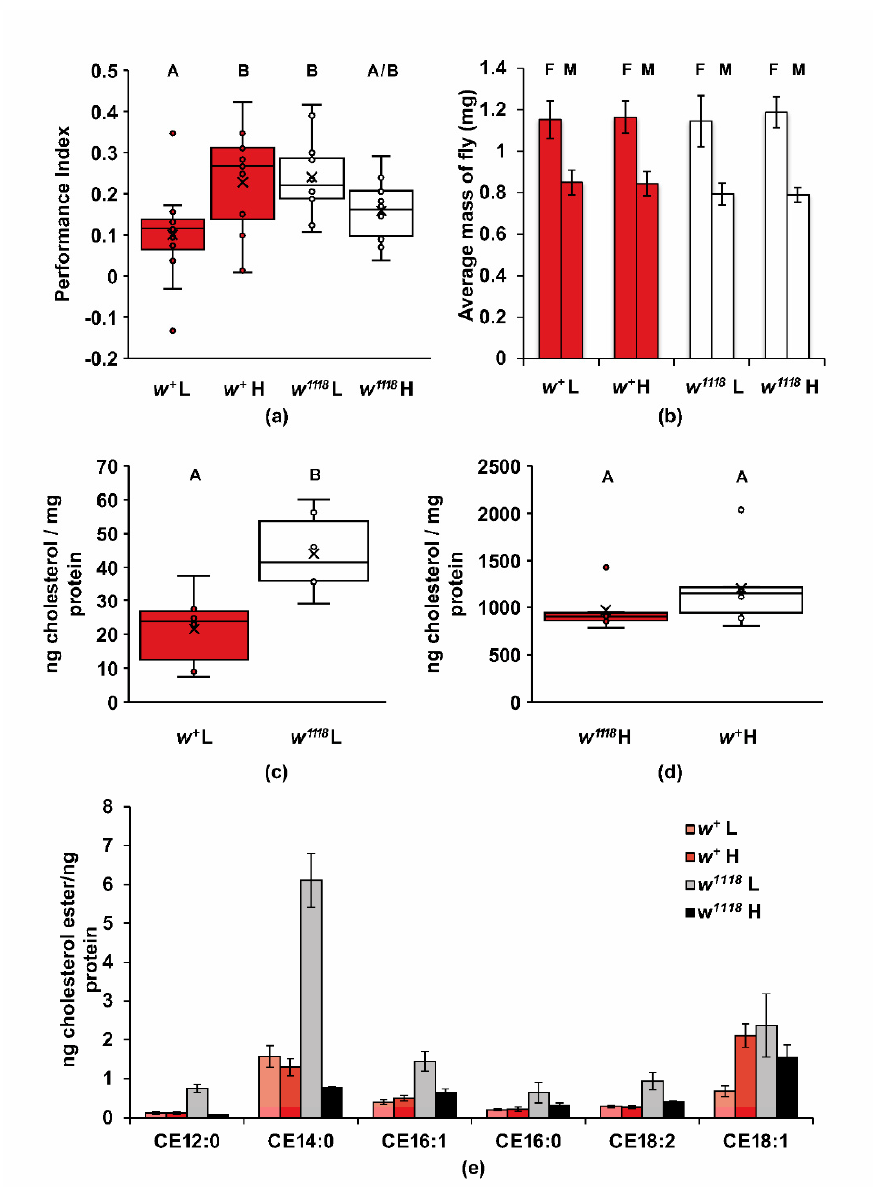
Figure 4. The w 1118 mutants have differential responses to dietary cholesterol in one-trial learning and in cholesterol accumulation in their corpses. Canton-S ( w + ) and w 1118 flies were reared on a low- or high-cholesterol (0.1 mg/mL added) diet. ( a ) Dietary cholesterol had a significant effect on one-trial learning (two-way ANOVA, Adj. R 2 = 0.183, F 3,44 = 4.508, p < 0.008; Tukey post hoc, p < 0.05; n = 12). Lower dietary cholesterol led to impaired learning in wildtype flies ( p < 0.05), but not in w 1118 mutants ( p = 0.249); ( b ) fly mass was unaffected by genotype or dietary cholesterol for both males and females (two-way ANOVA, Adj. R 2 = − 0.138, F 3,19 = 0.111, p = 0.952, n = 5–6); ( c ) the cholesterol levels in the w 1118 mutants were significantly higher than wildtype flies grown when both were raised on the low-cholesterol diet ( t (10) = 3.292, p < 0.01, n = 6); ( d ) The cholesterol levels in w 1118 mutants were not significantly higher than wildtype flies grown when both were raised on the high-cholesterol diet ( t (10) = 1.185, p = 0.263, n = 6); ( e ) w 1118 mutants raised on the low-cholesterol diet have greatly increased cholesterol esters compared to wildtype controls and w 1118 mutants raised on the high-cholesterol diet ( n = 3).